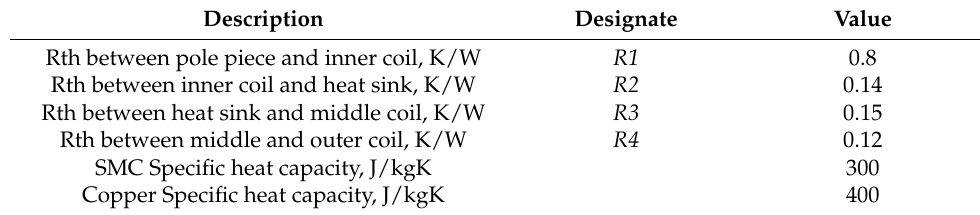
Table 9. Experimental fit for R th for conventional